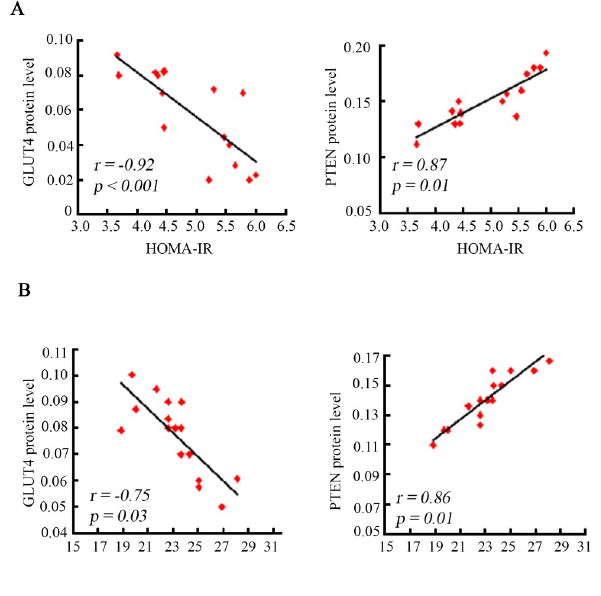
Fig 4. GLUT4 and PTEN protein levels were correlated with insulin resistance in the IUGR offsprings. Association analysis was conducted between GLUT4 or PTEN protein levels and the insulin resistance index (HOMA-IRI) at 2 (A) and 4 months (B) of age after birth in IUGR offsprings. The abundance of GLUT4 was negatively correlated with HOMA-IRI, and PTEN was positively correlated with